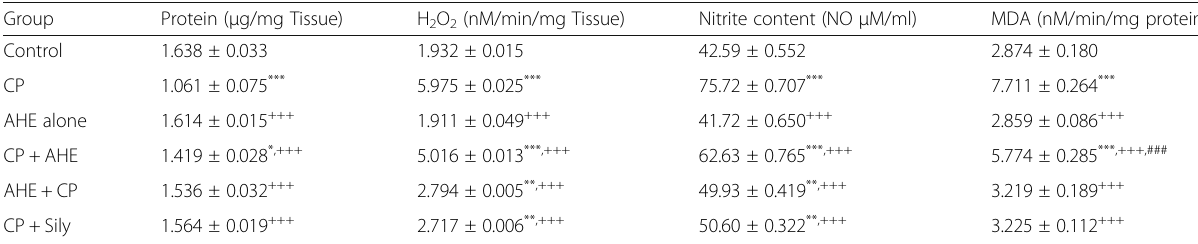
Table 5 Effect of cisplatin (CP) and different treatments of AHE on cardiac tissue protein, oxidative stress markers and lipid peroxidation